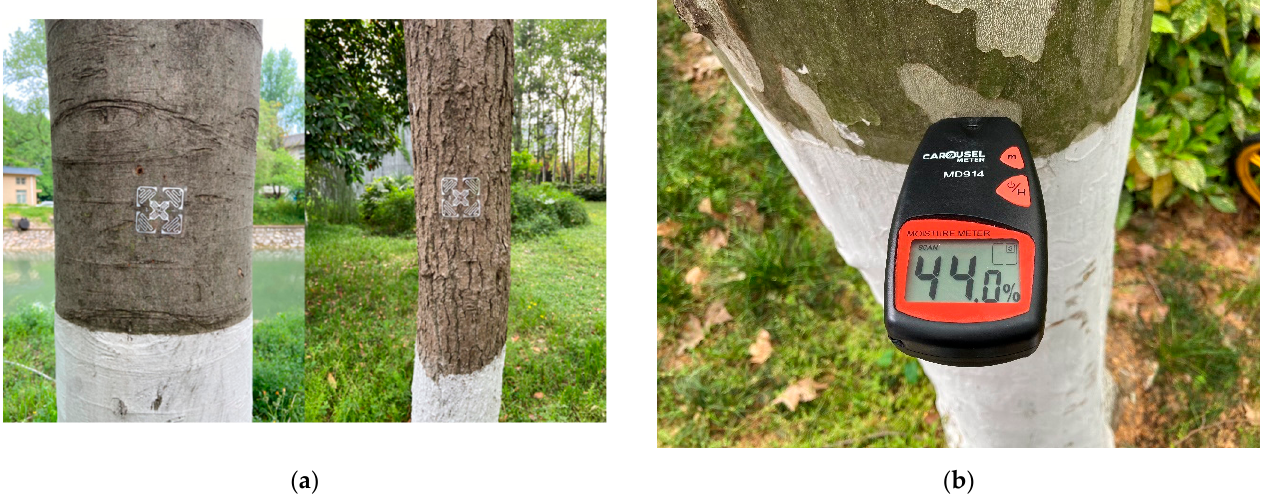
Figure 9. Measurements on standing trees. ( a ) shows the schematic diagram of sticking labels on the standing trees, and ( b ) shows the actual moisture content of trees calibrated with MD914.